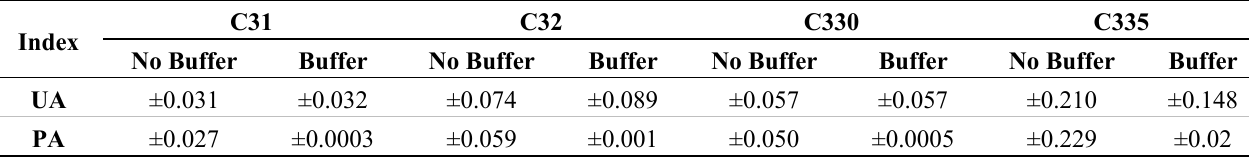
Figure 8. Comparison between GlobeLand30 2010 and DUSAF4.0 (II reclassification): per-classes statistics referred to 30 m resolution input datasets. C31: forests; C32: herbaceous or/and grass vegetation associations; C330: open spaces with little or no vegetation; C335: glaciers and perpetual snow. Table 11. Comparison between GlobeLand30 2010 and DUSAF4.0 (II reclassification): per-classes confidence intervals at 95% probability calculated for user (UA) and producer (PA) accuracies. Data refer to 30 m resolution input